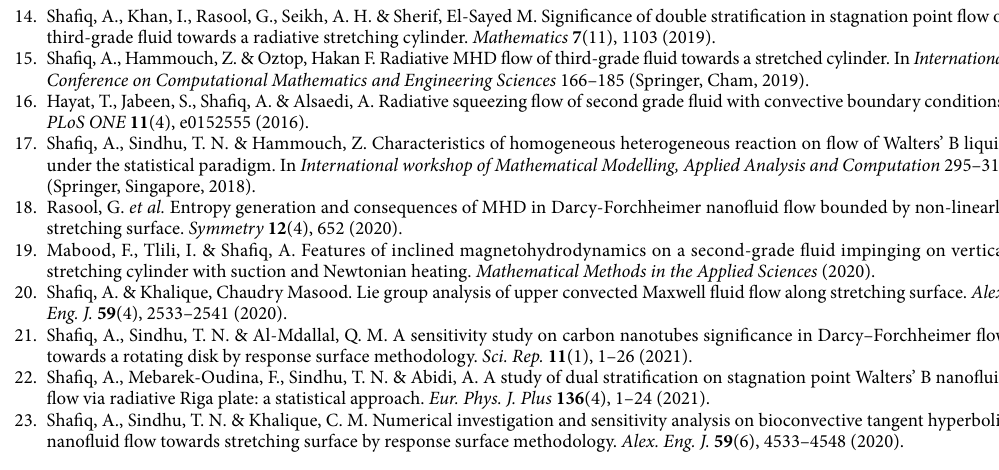
Table 4. Numerical values of Nusselt number Re − S 0.0.2, W e 0.4, γ 1 0.2 1 = = =